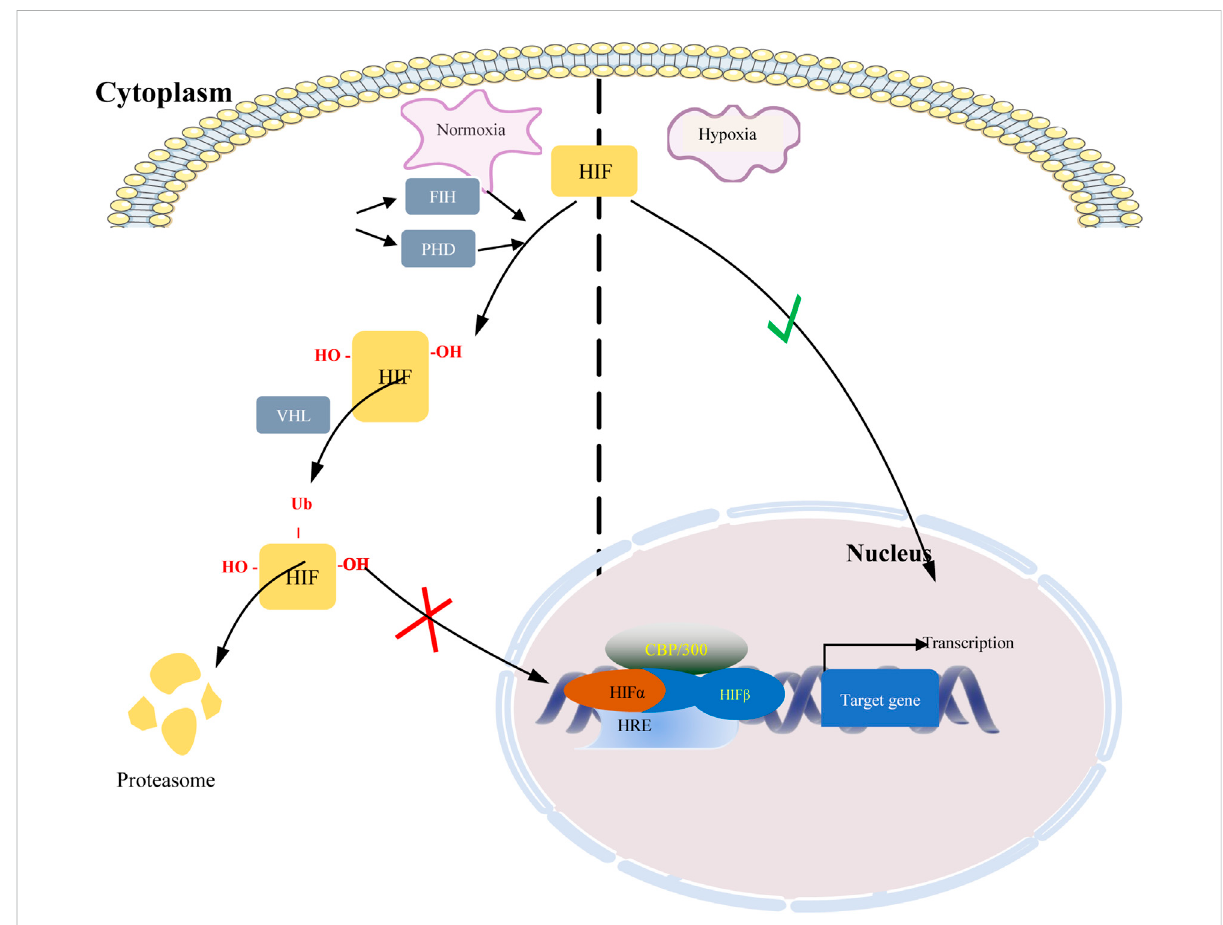
FIGURE 2 Regulation ofHIF under normoxic and hypoxic conditions.When oxygen isabundant,HIF is hydroxylated by prolyl hydroxylase domainprotein (PHD) enzymes at two speci fi c proline residues, enabling it to bind VHL. VHL targets hydroxylated HIF subunits for ubiquitin-mediated proteasomal degradation.Underhypoxicconditions,inactivationofPHDandFIH-1resultsinHIFstabilizationandtranslocationintothenucleuswhereitstabilizes and dimerizes with HIF-1 β , which together with the co-transcription factors p300 and CBP, drives hypoxia Transcription of target genes of response elements